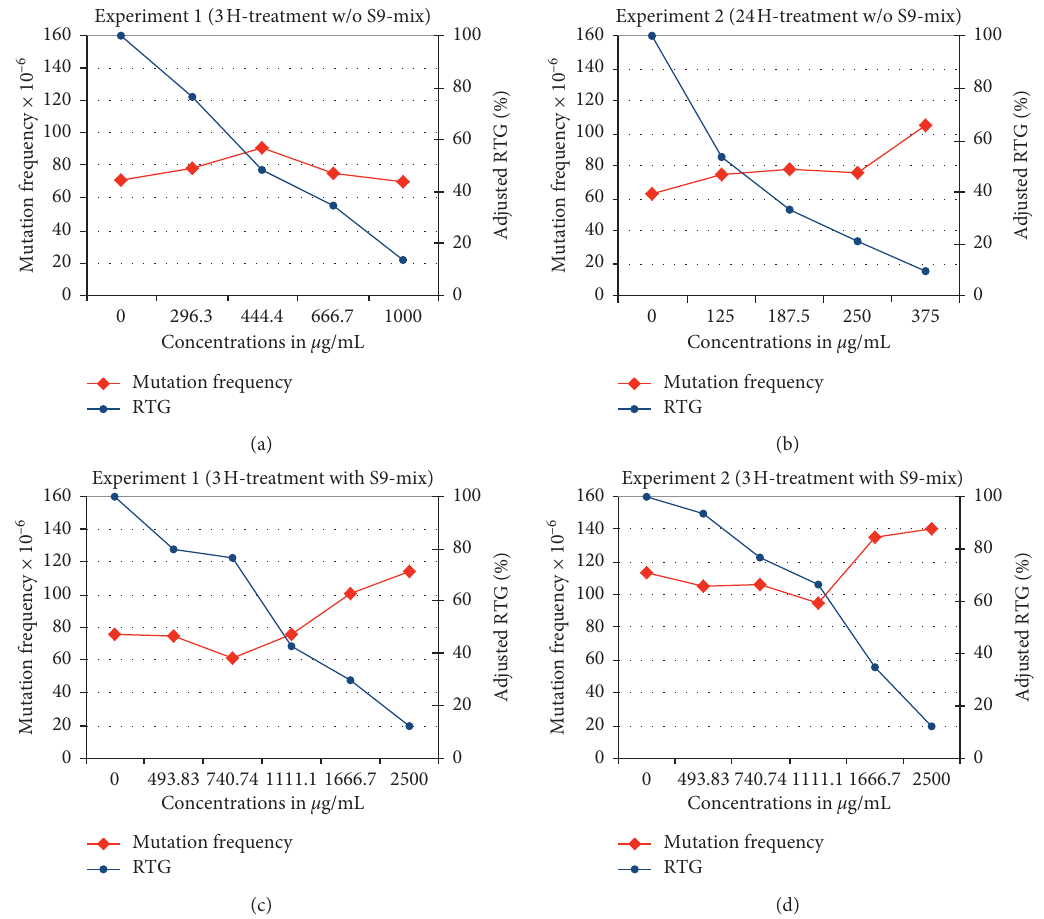
Figure 2: Results for the mouse lymphoma thymidine kinase gene mutation assay in absence and in presence of metabolic